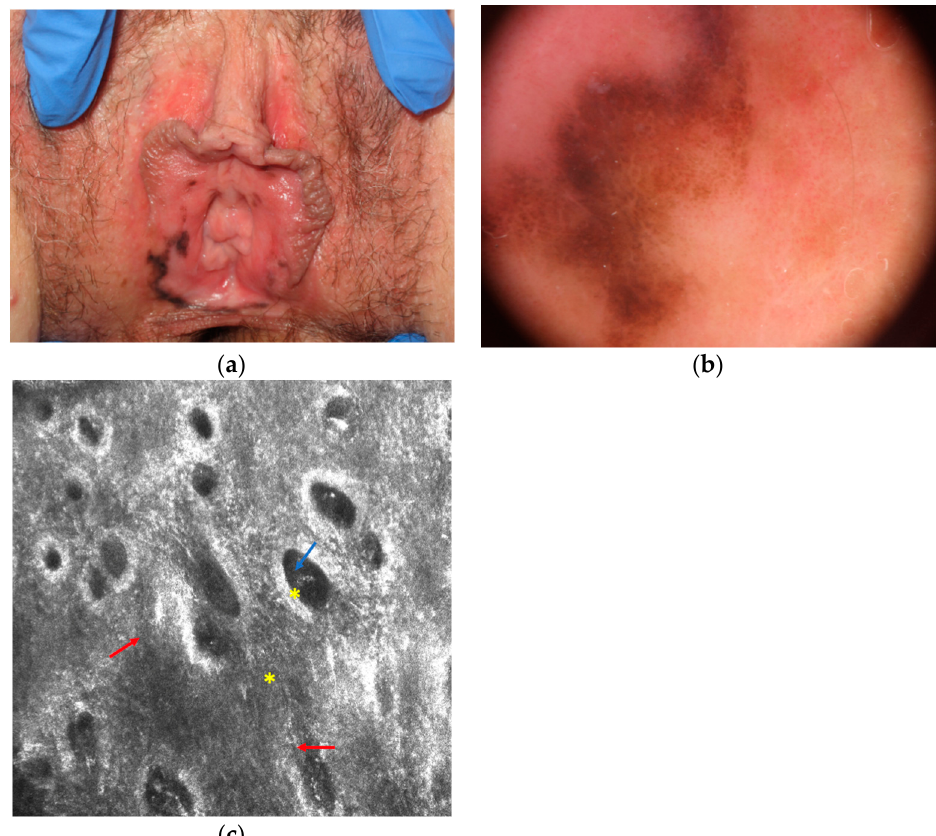
Figure 2. Melanotic macule that is difficult to differentiate from melanoma at clinical ( a ), dermoscopical ( b ) and reflectance confocal microscopy ( c ) examination. Reflectance confocal microscopy ( c ) at the dermal-epidermal junction level shows atypical dendritic cells in the basal layer of the epithelium (red arrows) and normal pigmented epithelial cells (blue arrow) around chorion papillae (yellow asterisk; images acquired with VivaScope 3000, Caliber, New York, NY, USA).